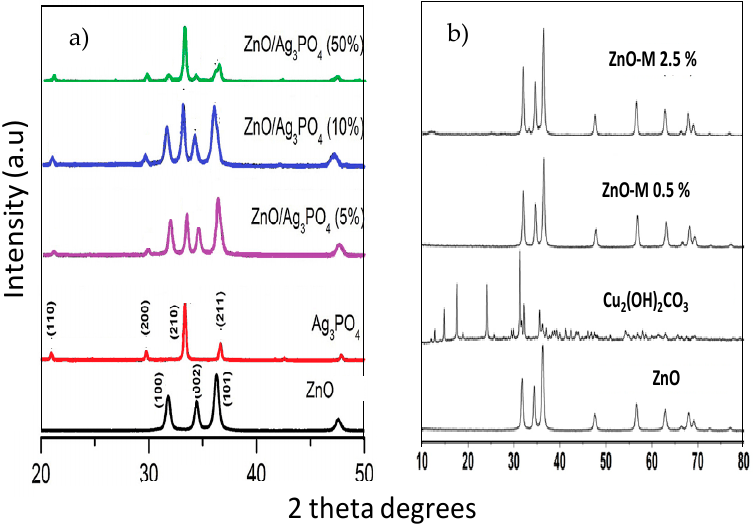
Figure 2. ( a ) X-ray diffraction patterns for the ZnO/Ag 3 PO 4 and ( b ) ZnO–malachite composites. Figure 2b. depicts the diffractograms for ZnO–malachite composites. Only peaks corresponding to ZnO Wurtzite can be observed. Even for the sample with the highest malachite content, no peaks associated with this mineral can be seen. This is probably due to the low amount and good dispersion of malachite on the ZnO matrix; however, the XRF results show that in the ZnO-M materials there are different Cu concentrations, which are dependent on the nominal amount added during synthesis.